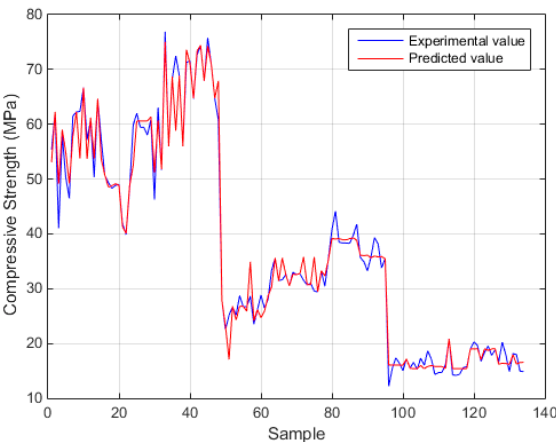
Figure 6. The Pearson’s correlation coefficient R of the experimental and predicted compressive strength for the best with two hidden layers BPNN (5-7-7-1).